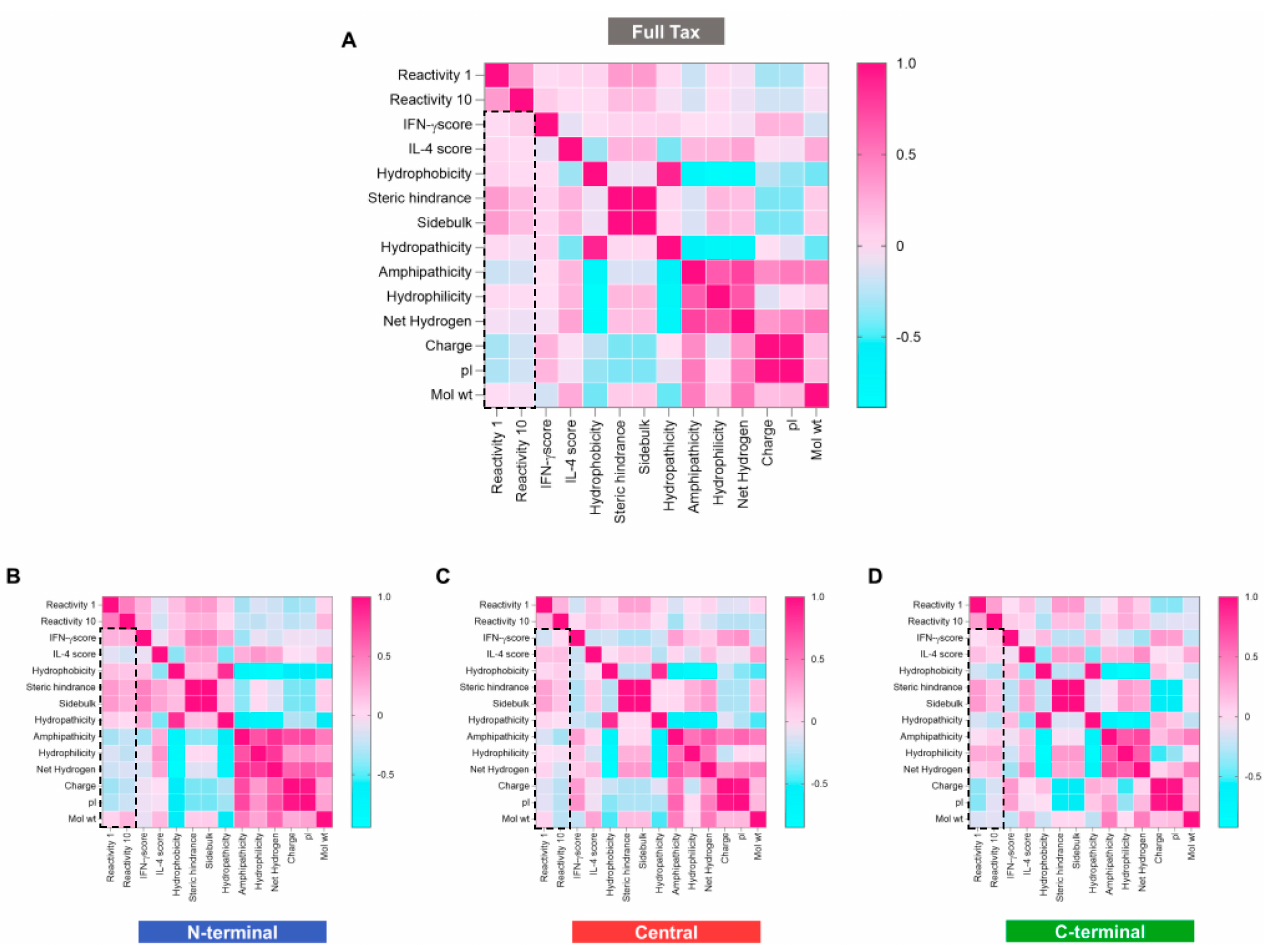
Figure 6. Correlations among physicochemical properties of HLA-A*02-restricted peptides versus reactivity of peptides to the HLA-A*02-01 haplotype at low (1 µg/mL) and high (10 µg/mL) concentrations. Spearman correlation demonstrated by heatmap according to full Tax protein ( A ) and N-terminal ( B ), Central ( C ) and C-terminal ( D ) regions. The black rectangle in the dotted line represents the HLA-A*02:01 reactivity of Tax peptides.